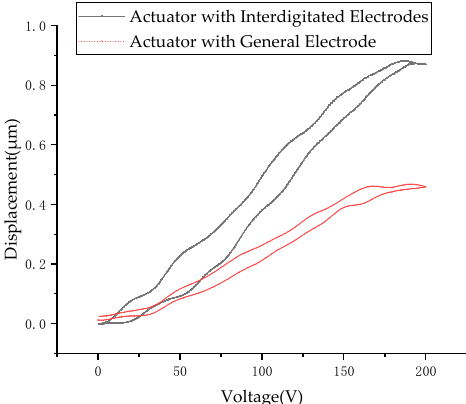
Figure 15. A plot of the output displacement versus the voltage.